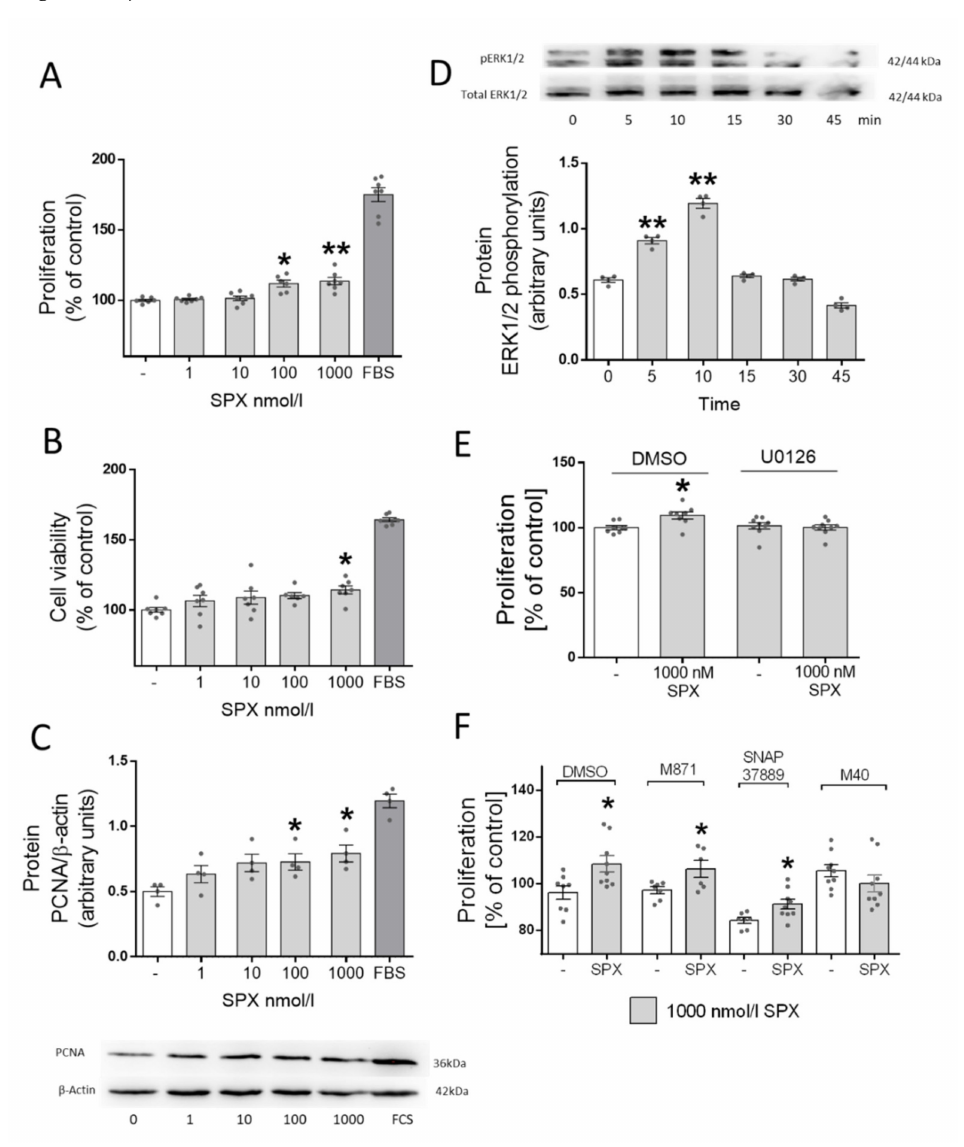
Figure 2. The effect of SPX on proliferation ( A ), cell viability ( B ), PCNA protein expression ( C ) and ERK1/2 phosphorylation ( D ). The effect of SPX on proliferation with or without ERK1/2 pharmacological blockers ( E ). The effect of different SPX on proliferation in the presence of different galanin receptor antagonists ( F ). Values are presented as mean ± standard error of the mean (S.E.M.) (( A , B , E , F ) n = 6, 7; ( C , D ) n = 4). Statistically significant differences are marked for p < 0.05 (*) and p < 0.01 (**) compared to the corresponding